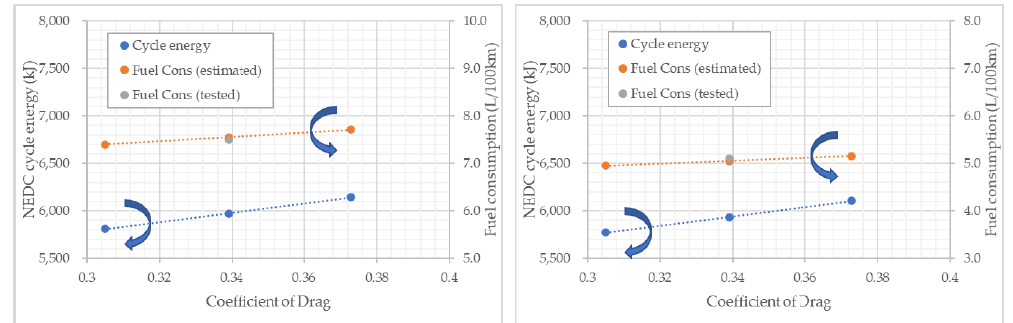
Figure 21. Effect of the aerodynamic drag (drag coefficient) on the cycle energy and fuel consumption Figure 21. E ff ect of the aerodynamic drag (drag coe ffi cient) on the cycle energy and fuel consumption in the NEDC mode (left/right: gasoline/diesel). in the NEDC mode (left / right: gasoline /